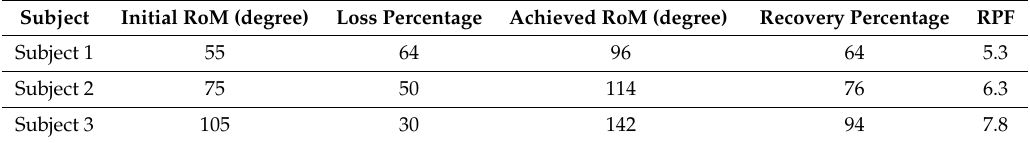
Table 3. Table of clinical